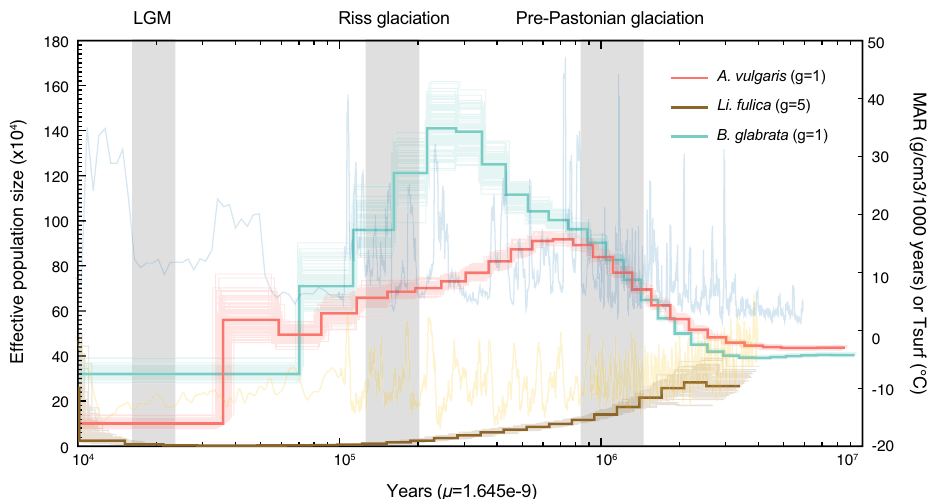
Figure 6. Demographic histories of Arion vulgaris , Lissachatina (Achatina) fulica and Biomphalaria glabrata. Solid bold lines indicate inferred ancestral effective population sizes for three species, while background blue and yellow lines represent the mass accumulation rate (MAR) and the atmospheric surface air temperature (Tsurf) relative to the present,